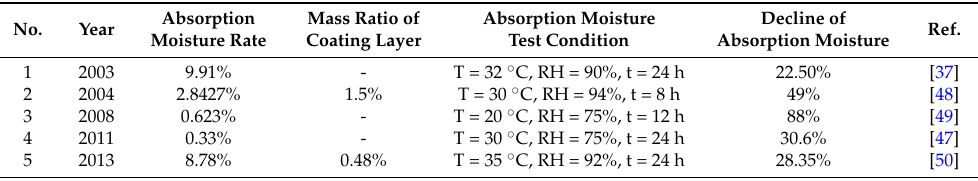
Table 3. Performance of coated AN using the encapsulation coating